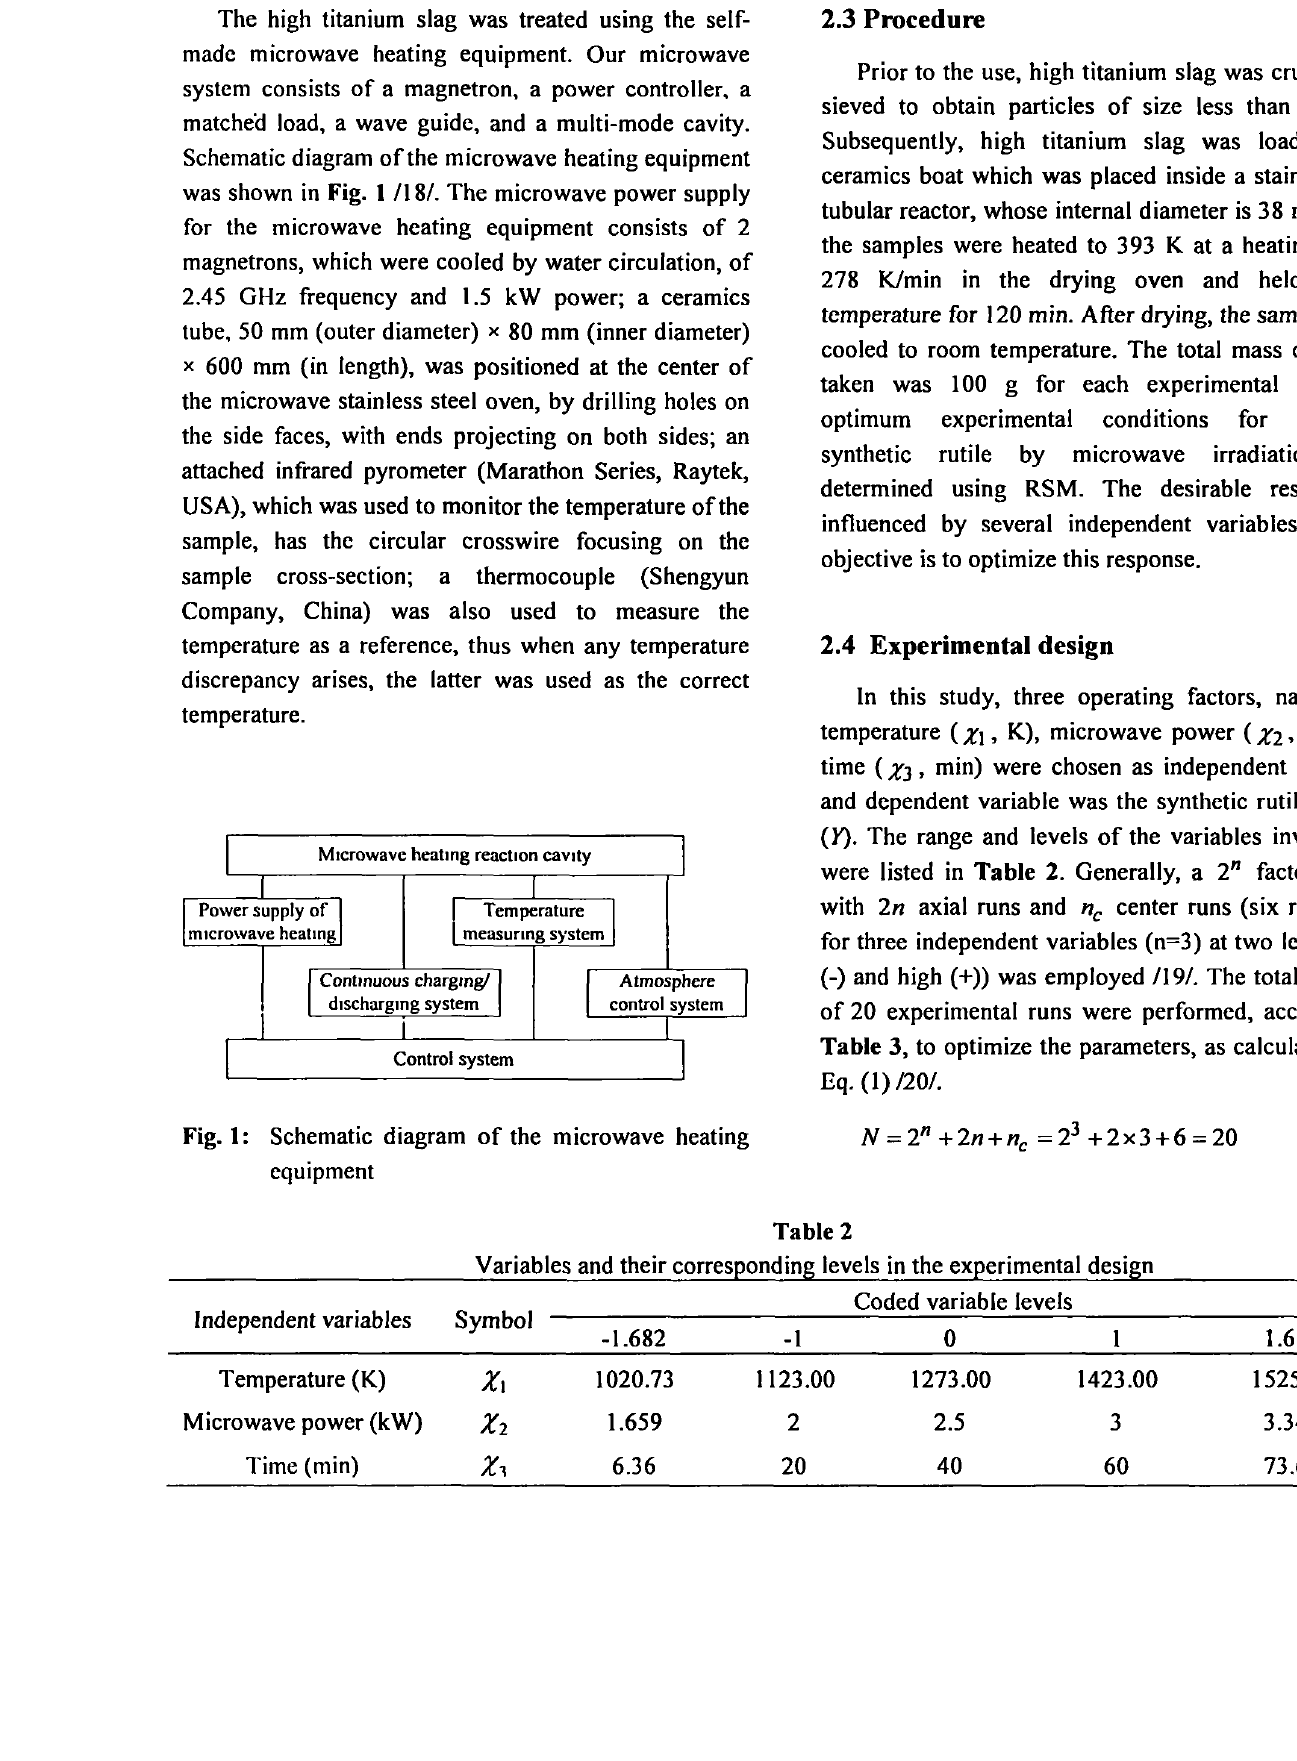
Variables and their corresponding levels in the experimental design Independent